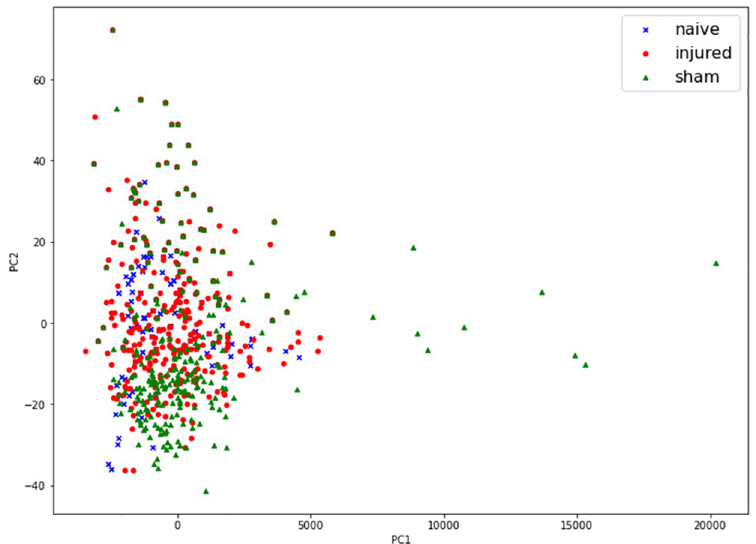
Fig 7. Principal component analysis plot of the dataset with two components. Two clusters, injured and sham have started forming although there is some overlap between the two groups. Naive data currently overlaps with other two major classes, however, more data may provide a better visual representation of the location of the naive cluster. Overall, it is not straightforward to distinguish the three experimental groups on the PCA map, indicating that the classification task is